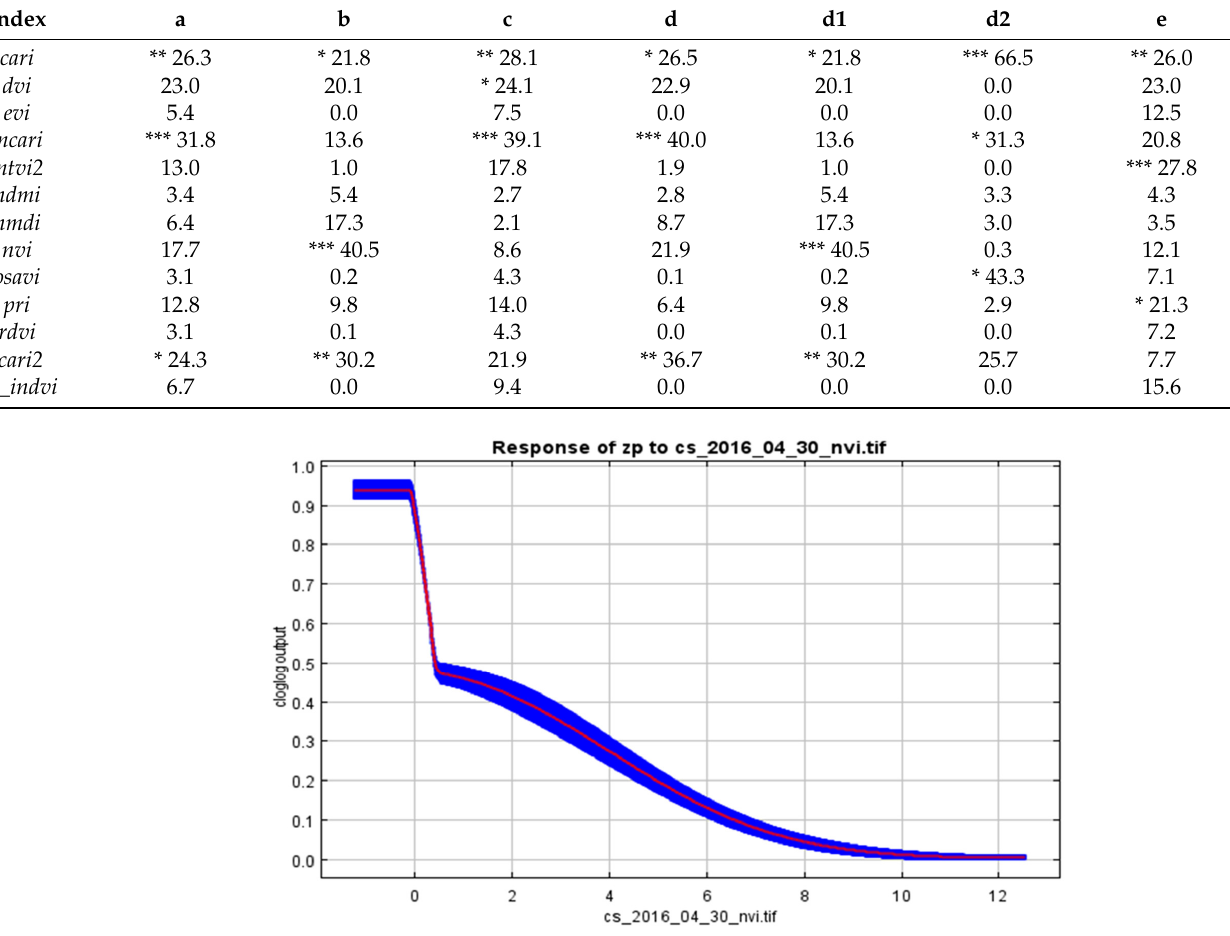
Table 5. Average percentage of the contributions of individual hyperspectral indices for identifying waterlogged areas. Variants: a—all cases, b—spring period, c—autumn, d—site 1, d1—site 1, spring,